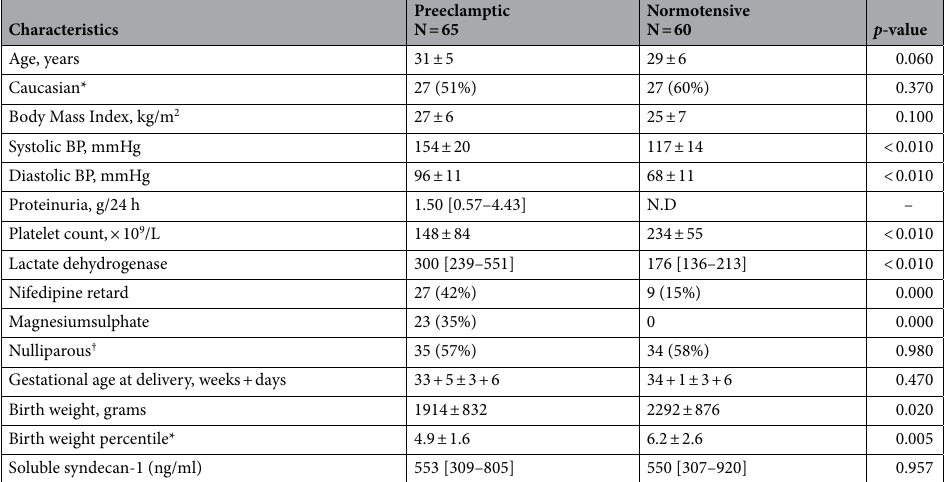
Table 1. Clinical characteristics with comparison of normotensive pregnant women and women with pre- eclampsia. Numbers represent mean ± standard deviation, median with [interquartile range], or number of subjects with percentages. † Data missing for 4 women with pre-eclampsia and 1 normotensive woman. *Data on birth weight percentile missing for 18 women with pre-eclampsia and for 8 normotensive women. Between group differences were assessed by t-test for parametric, Mann–Whitney U test for non-parametric distributions and Chi square test for nominal variables. p -values were considered to indicate a significant difference if p <